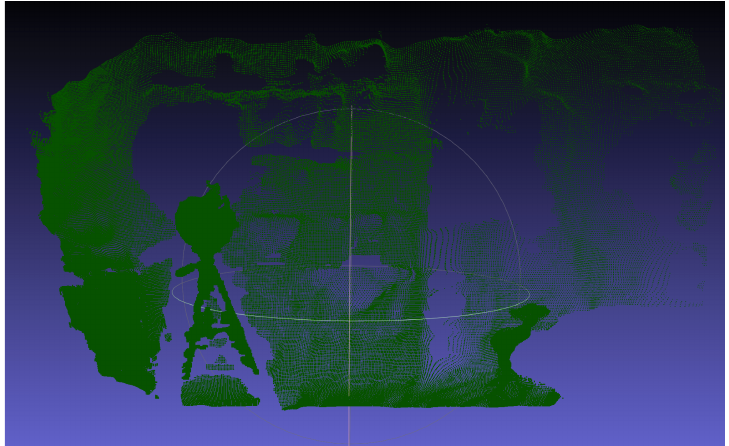
Figure 11. Experiment scene 1 3D point cloud, visualization of the PLY file with Meshlab software.